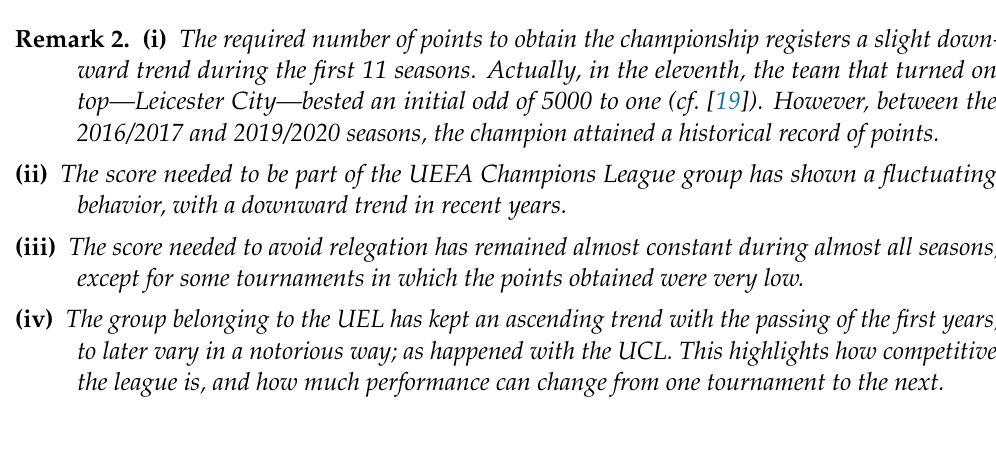
Figure 4. Evolution of the number of points needed to belong to each of the first four